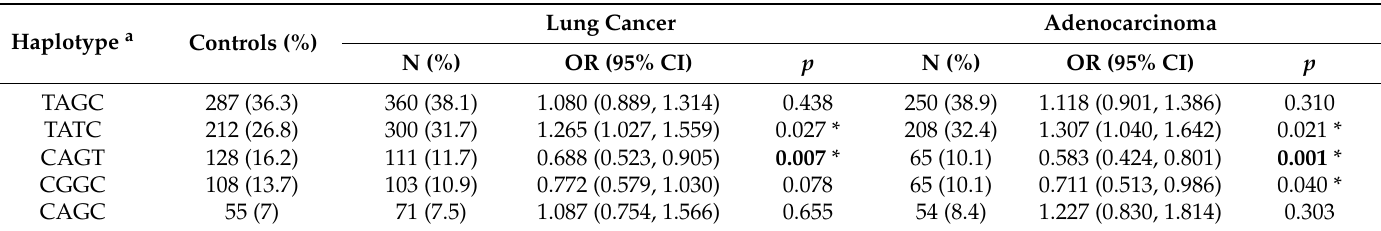
Table 5. Haplotypes and the risk of lung cancer (rs7813–rs2740349–rs2291778–rs910924).